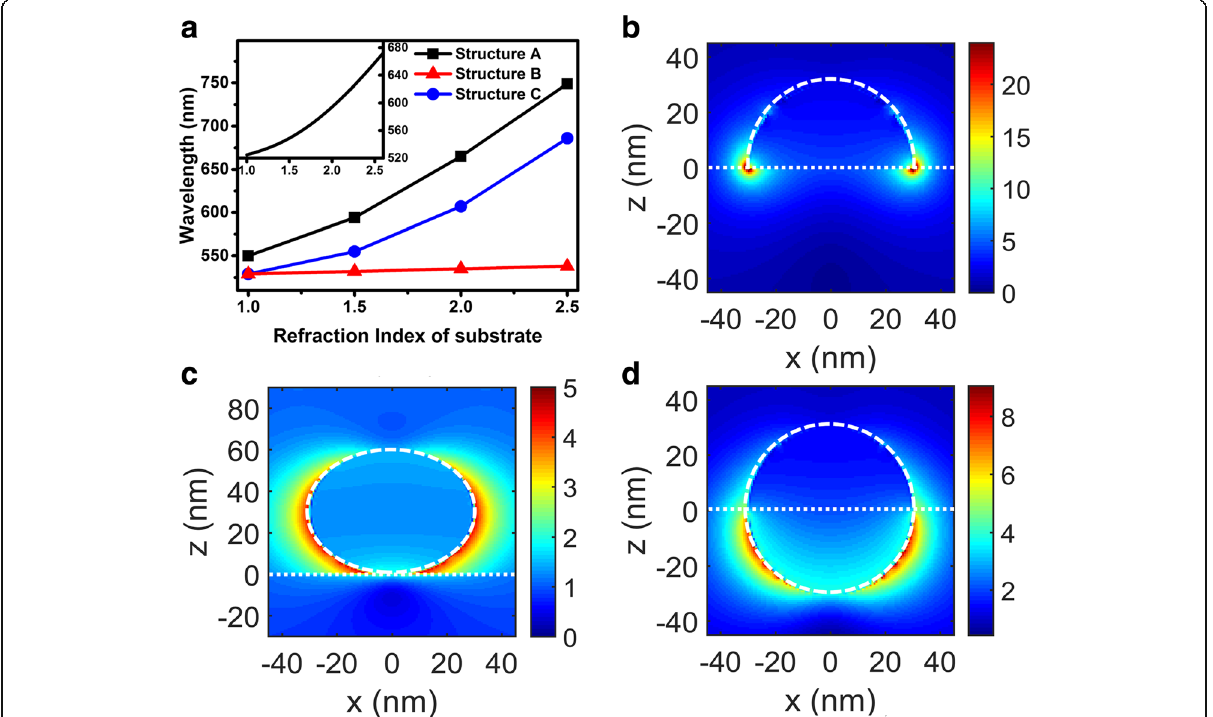
Fig. 2 a Scattering peak wavelengths of different structures with varying substrate refractive indices. The insert shows the relationship between the LSP coupling wavelength and refractive index of surrounding medium based on Mie theory. b – d Polarization electric field distributions of structure A to C with n 2 = 1.5 at the corresponding LSP coupling wavelength respectively